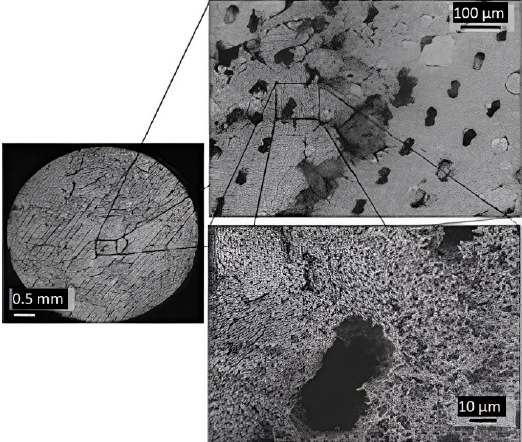
Figure 17. Sequential set of images showing the presence of the voids left from the binder that has been burned out after heating the sample at 1200 °C for 4 h (Reprinted from Ref. [99], copyright (2015), with the kind permission of Elsevier Ltd. and Techna Group S.r.l.).